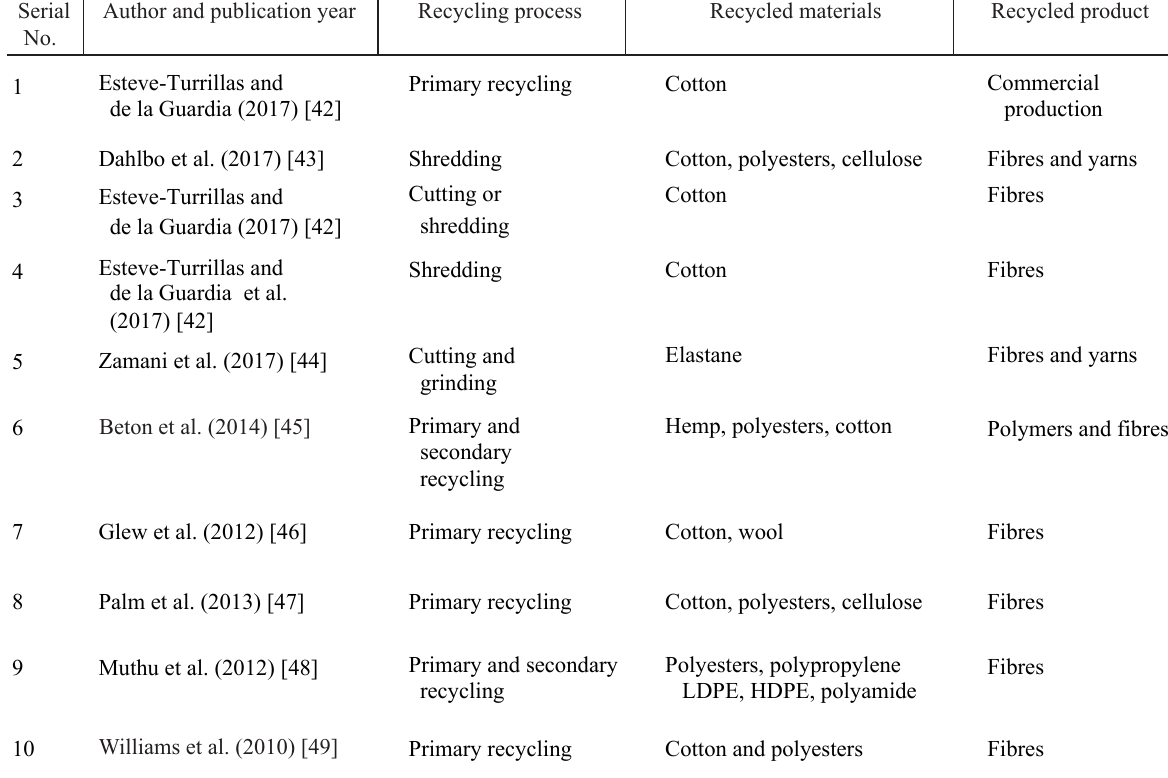
Table 2. Literature data of textile recycling and circular economy in the world